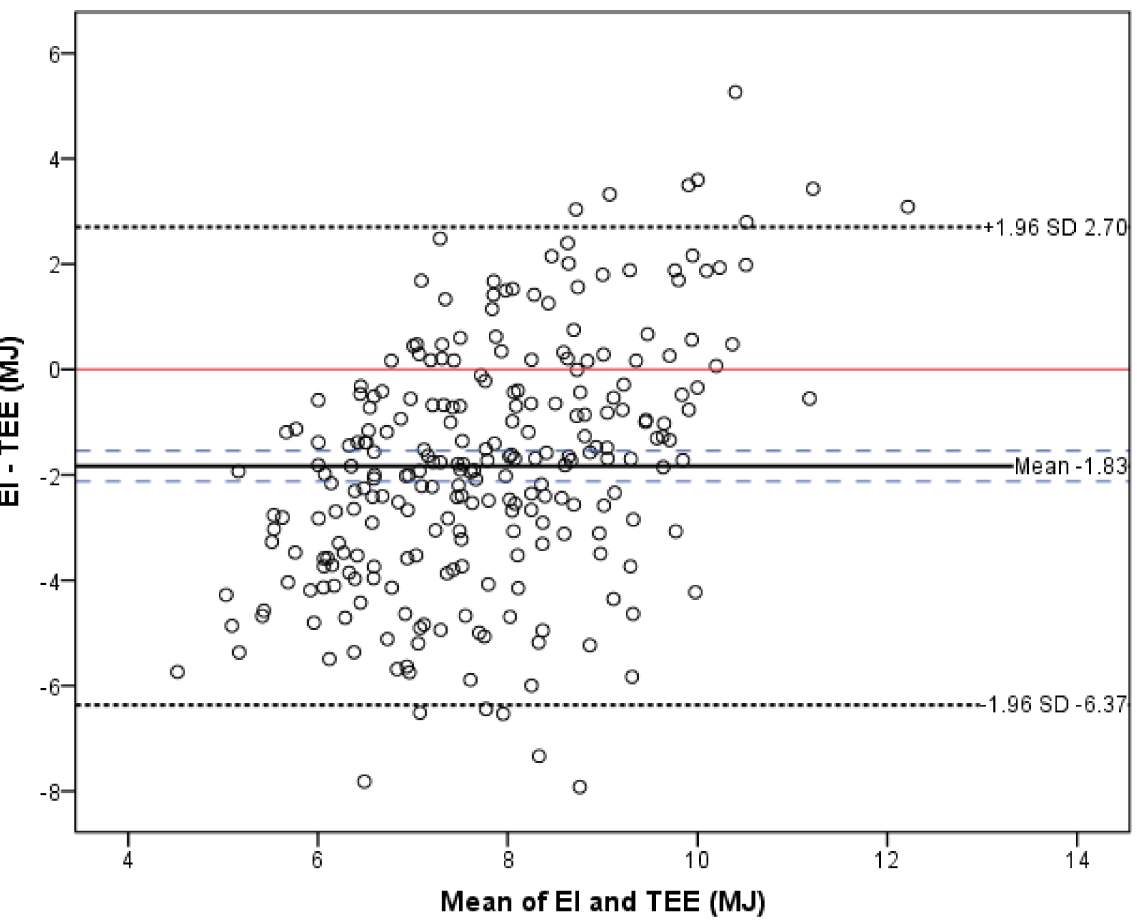
Fig 2. Bland-Altman plot displaying the difference between EI and TEE plotted against their mean. EI, energy intake; TEE, total energy expenditure; MJ, megajoule; SD, standard deviation. This visual plot demonstrates how the difference between estimated EI from a web-basedfood recall (WebFR) and TEE estimated based on accelerometer counts, combinedwith data on weight, sex or REE (Y-axis) varies with increasing levels on the scale (X-axis). The mean difference betweenEI and TEE is given by the solid thick line, together with the 95% CI for the mean, displayedin long stippledlines. The short stippledlines show +/- 1.96 SD of the mean difference betweenEI and TEE.